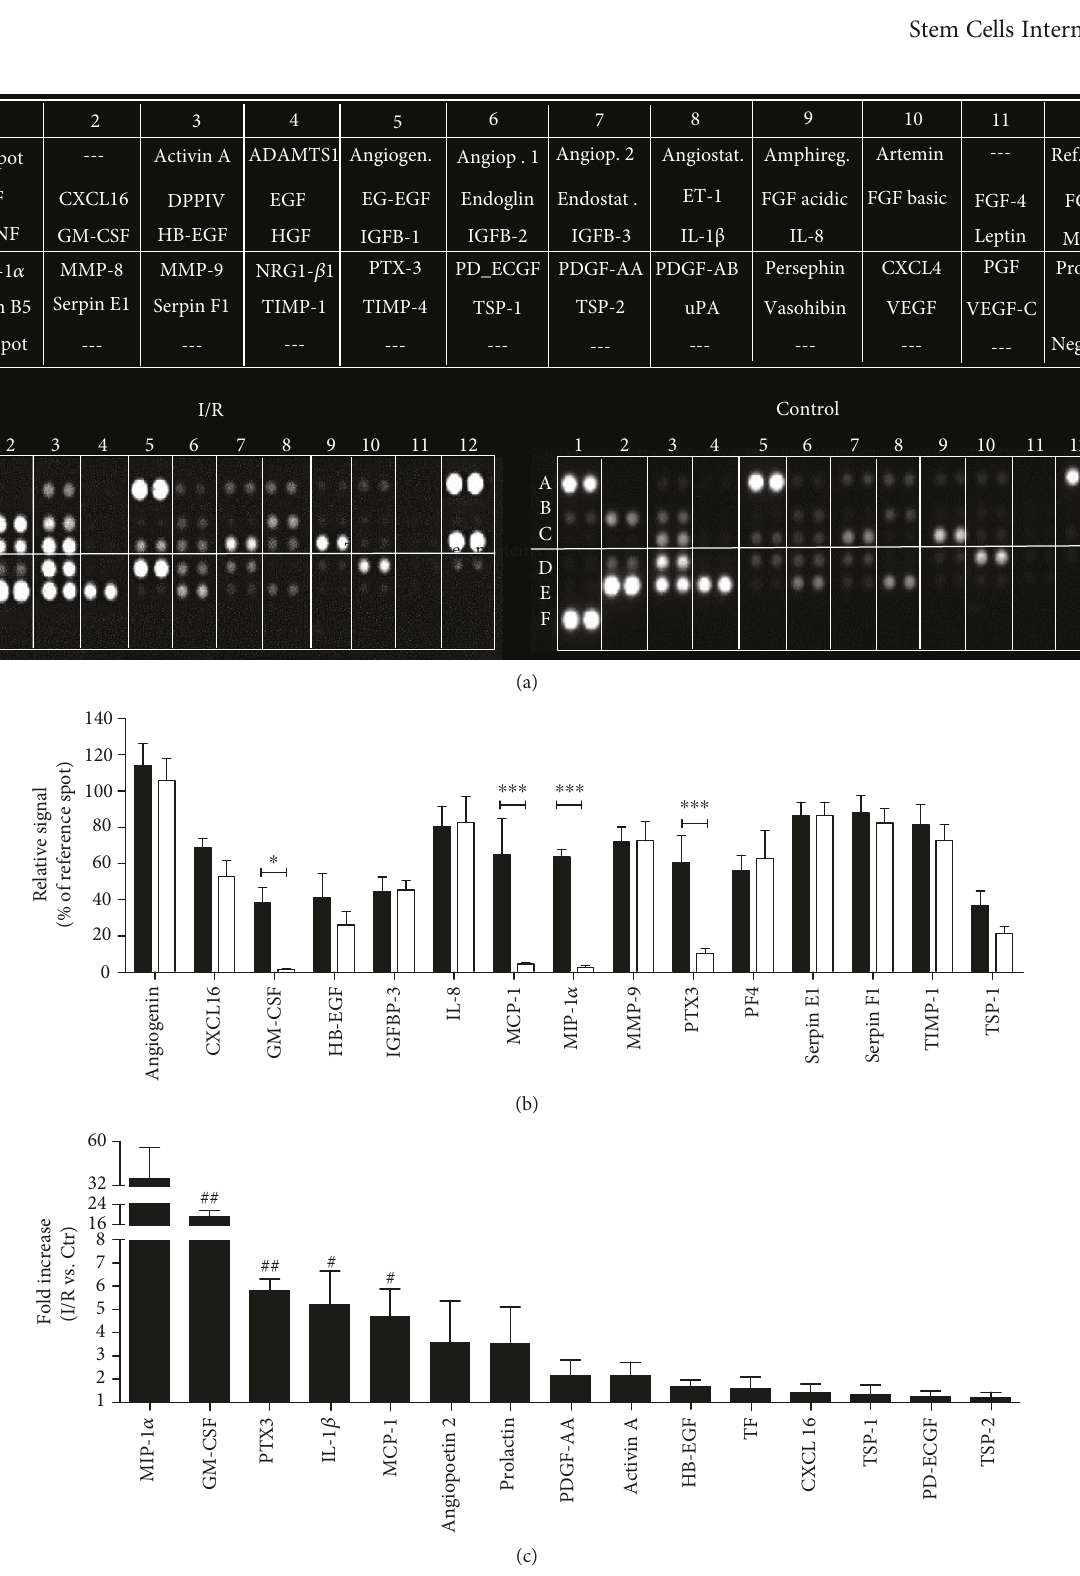
Figure 4: Evaluation of the e ff ects of I/R on angiogenic protein secretion. (a) Analyzed angiogenesis-related proteins and location on the respective array membranes; the lower panel shows one representative array (out of N = 5 ). (b) Angiogenic proteins with high levels of secretion. (c) Top 15 I/R-regulated angiogenic proteins. All proteins are presented as duplicate spots on the respective array membranes. For a detailed description of the array proteins, please refer to Supplement 2. I/R: ischemia/reperfusion; Ctr: control. ∗ p < 0 05 , ∗∗∗ p < 0 001 , Student ’ s t -test, # p < 0 05 , ## p < 0 01 , one-sample t -test, N = 5